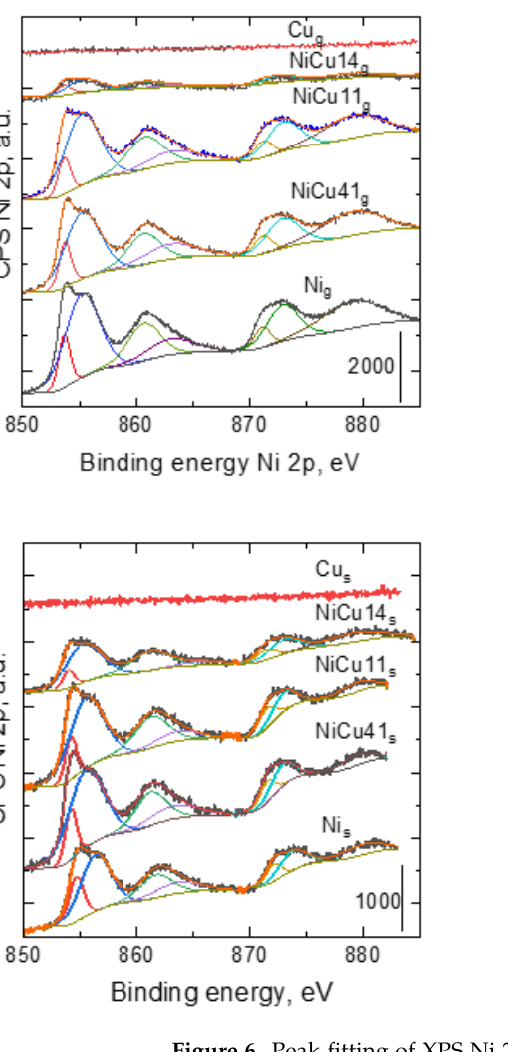
Figure 6. Peak fitting of XPS Ni 2p spectra ( top left ) and Cu 2p spectra ( bottom left ) of granular catalysts and Ni 2p spectra ( top right ) and Cu 2p spectra ( bottom right ) of sputtered catalysts. Table 6. Fractions of different oxygen species on the surface (%) according to O1s peaks after